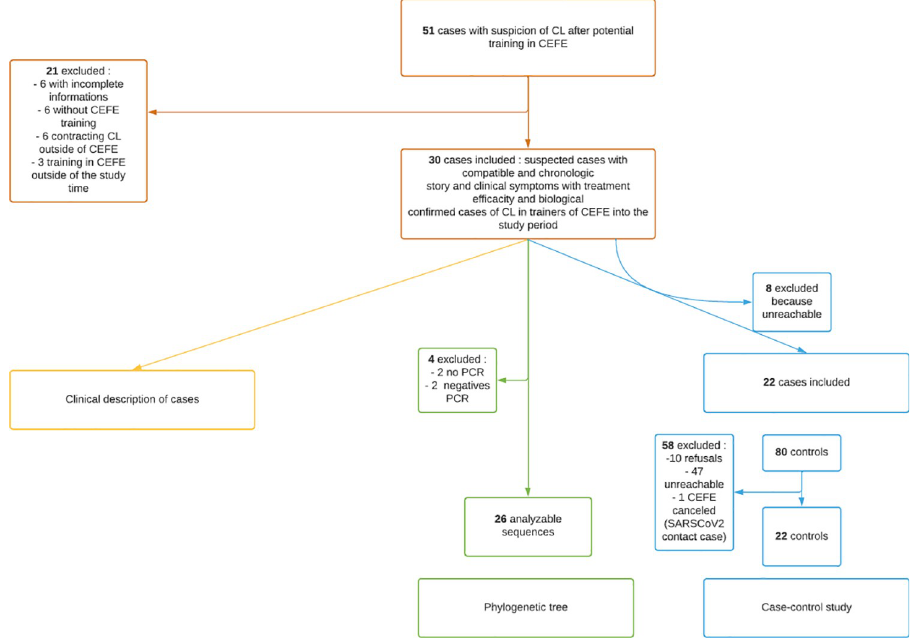
Fig 1. Flow chart of patients respectively included in the clinical description of cases, phylogenetic analysis and case-control study, CEFE outbreak, French Guiana, 2020.